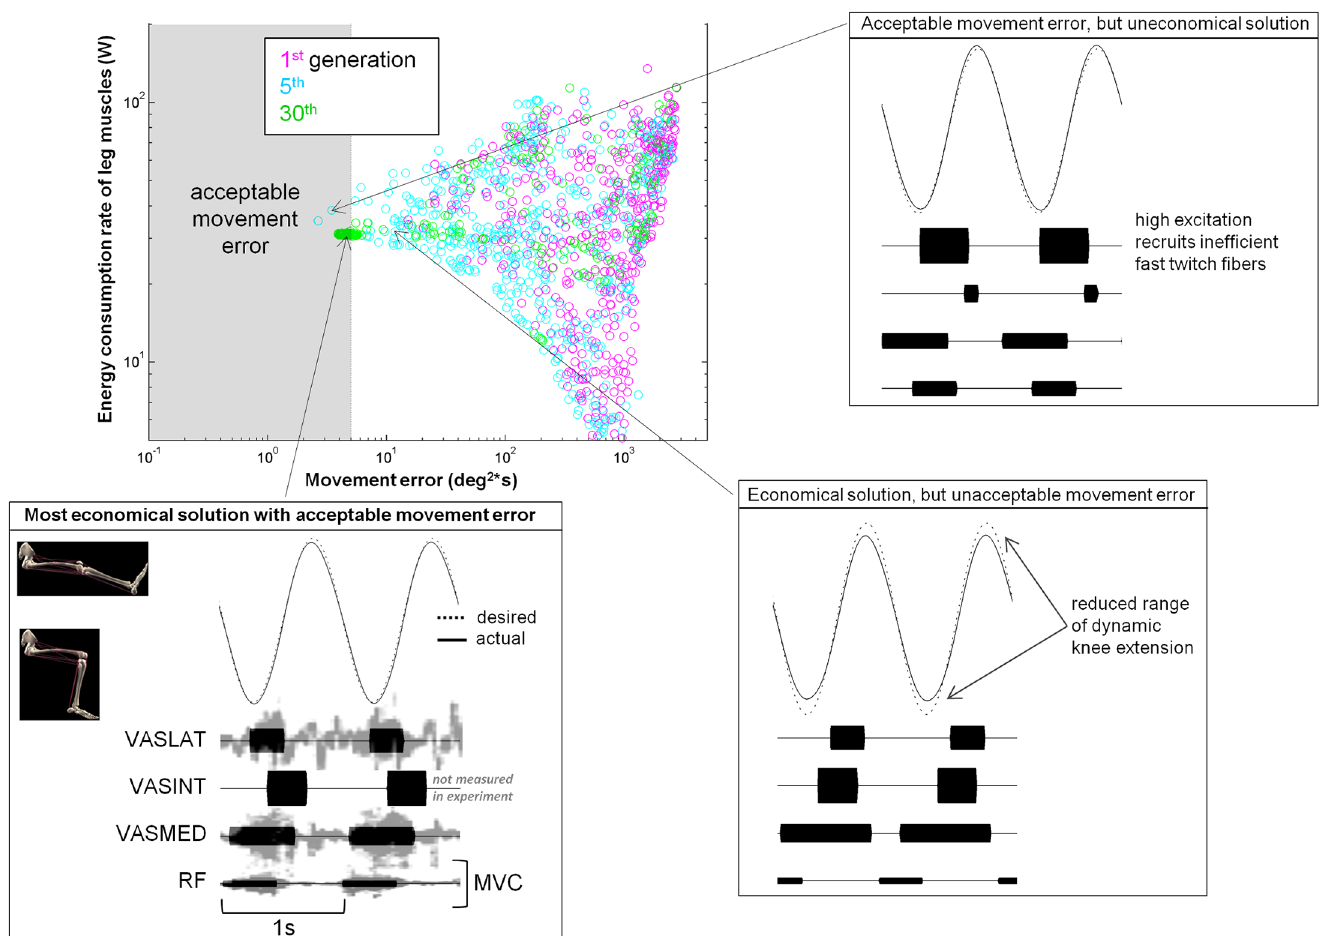
Fig 4. Exemplary optimization trial. The population of solutions discovered by the genetic algorithm is shown for the initial, intermediate, and final generations. Each point in this plot corresponds to one solution, or alternatively, one set of parameters that define the muscle excitation signals. Solutions are plotted in terms of their associated movement error and energy consumption. Solutions within the shaded region exhibited acceptable kinematics. The minimum energy solution that satisfied the kinematic criteria is shown on the bottom left. Experimental muscle activity is shown in gray [21] and is overlaid on model predictions to highlight similarities in timing. An exemplary solution with non-physiological kinematics is shown at the bottom right and non-physiological energetics is at the top right. Graphic of musculoskeletal model is a screenshot of the model we constructed in open-source software named MusculoSkeletal Modeling Software (MSMS;